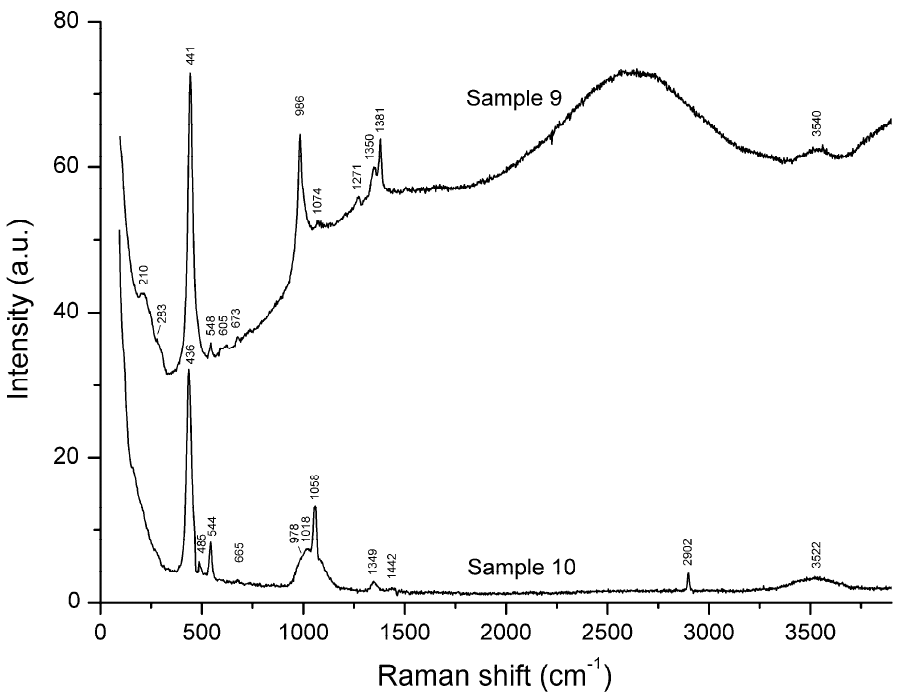
Figure 11. Raman spectra of the F-rich sodalite-group mineral (Sample 9) and the synthetic fluoraluminate sodalite-type compound (Sample 10).